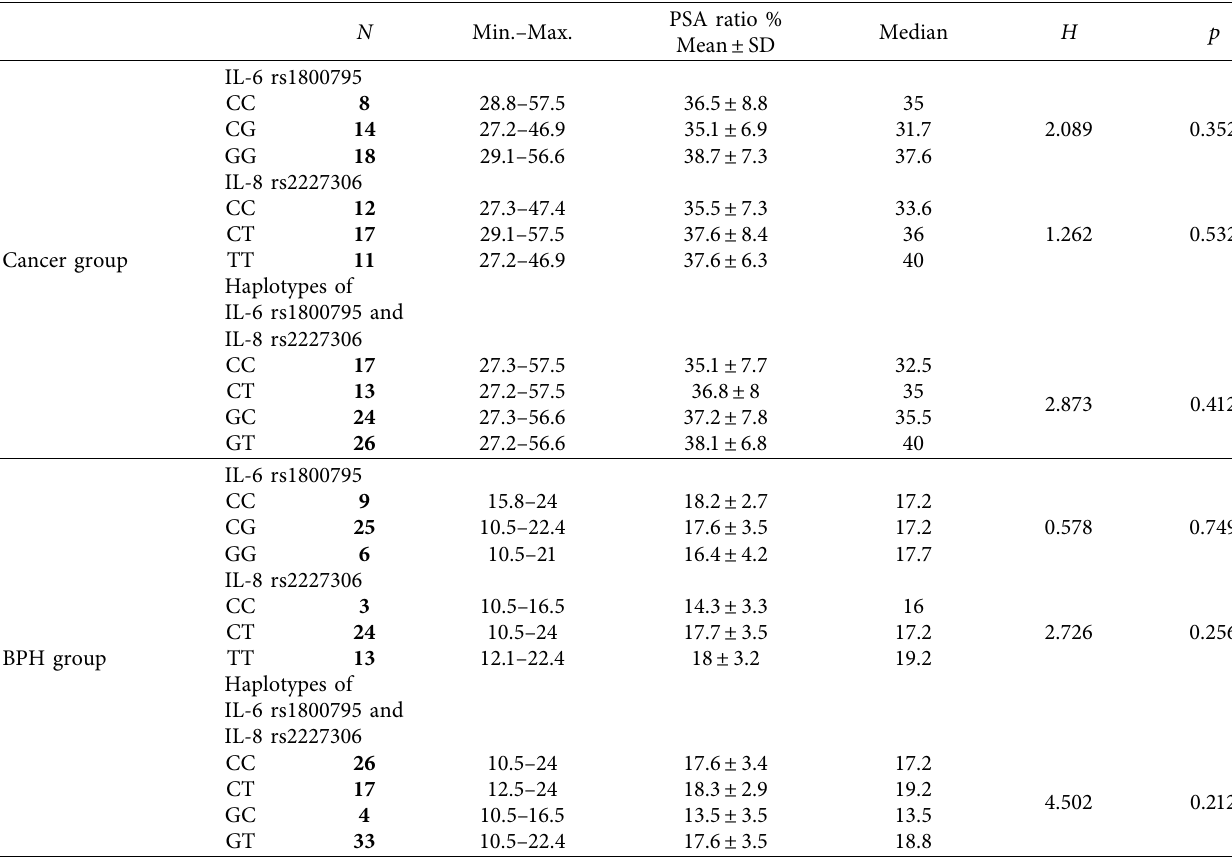
Table 6: Relation between PSA ratio with IL-6 rs1800795 and IL-8 rs2227306 in each patient group.